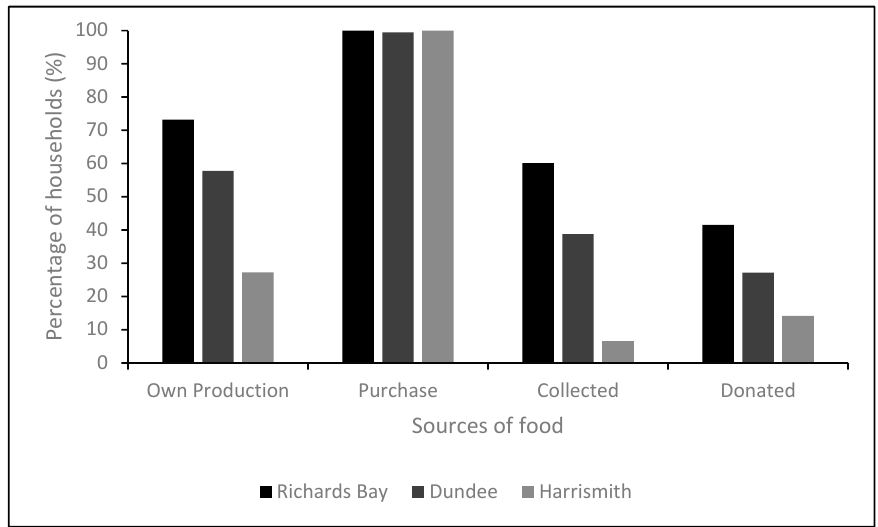
Figure 2. Percentage of women obtaining food from different sources.